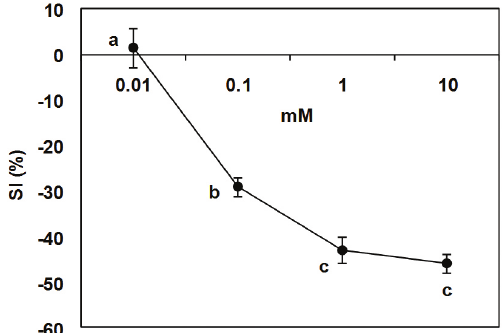
Figure 2. Plant sensitivity index (SI) in Salvinia auriculata Aubl. exposed to increasing concentrations of Cu. The different letters indicate significant differences ( p < 0.05) according to Tukey’s test.